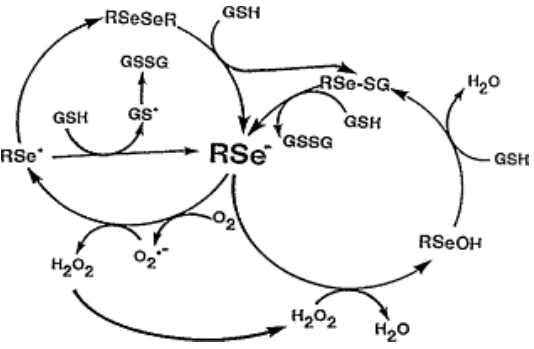
Figure 2. Redox cycling of methylselenide and other selenides (RSe −